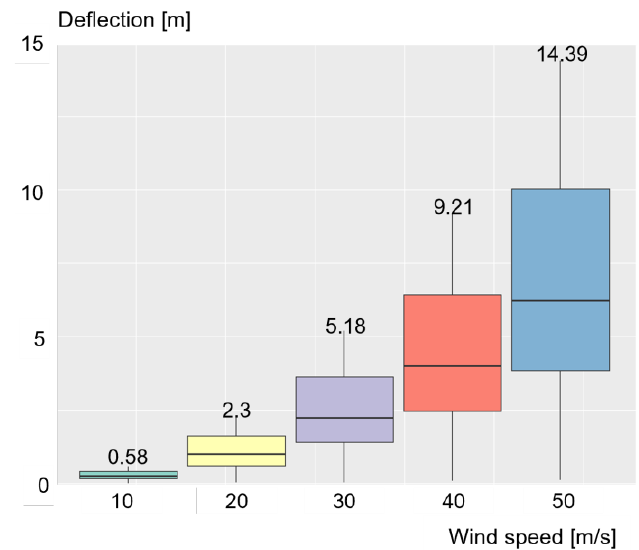
Figure 6. The relationships between tree deflection and the wind speed.